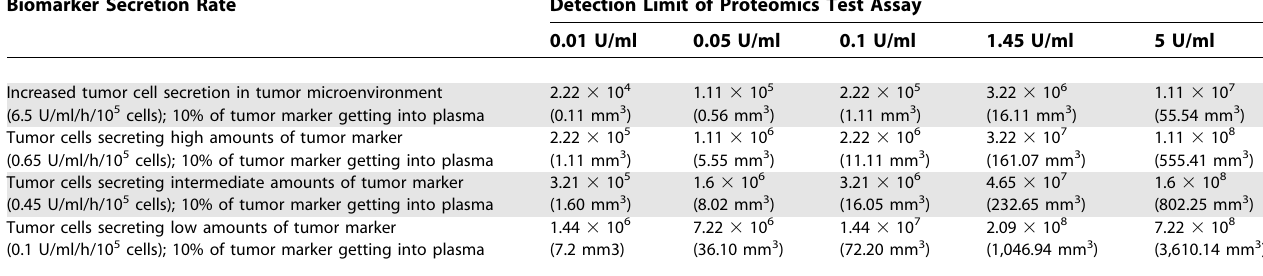
Table 5. Minimum Detectable Tumor Cell Number and Estimated Tumor Size (in mm 3 ) as a Function of CA125 Proteomics Test Assay